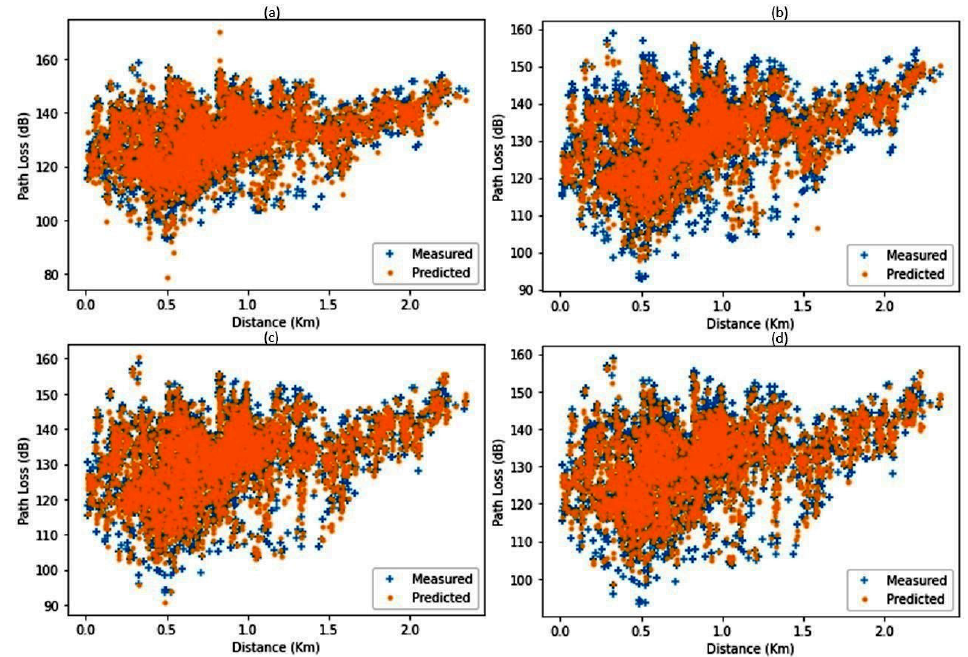
Figure 18. Predictions in urban (1800 MHz) environment based on ( a ) DRS on dataset 1, ( b ) DES on dataset 1, ( c ) DRS on dataset 2, ( d ) DES on dataset 2.